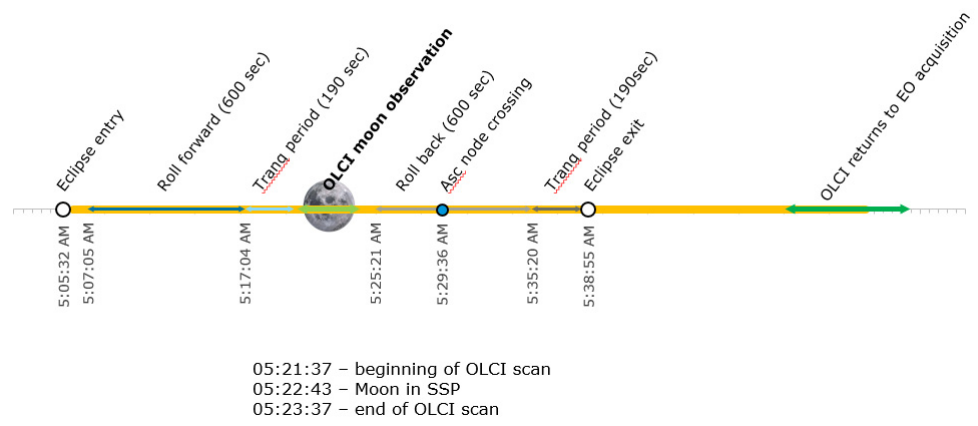
Figure 2. Timeline of OLCI-B Moon Observation.